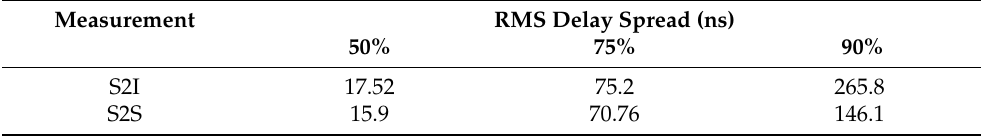
Table 3. Statistical result of the RMS delay